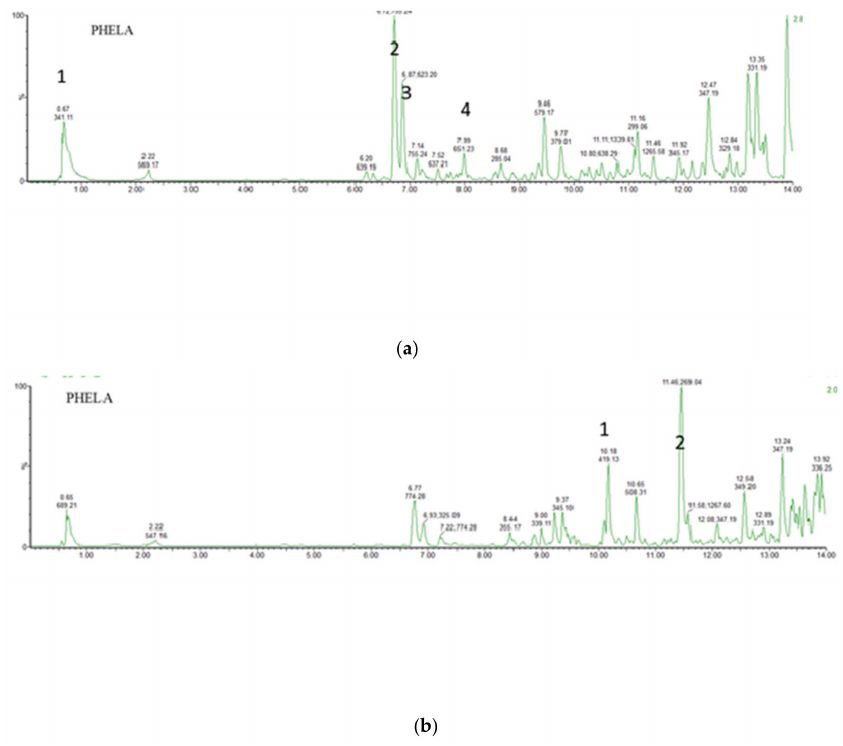
Figure 1. UPLC-QTOF-MS/MS total ion chromatogram for PHELA ® extract in negative ionization mode ( a ) and negative ionization mode ( b